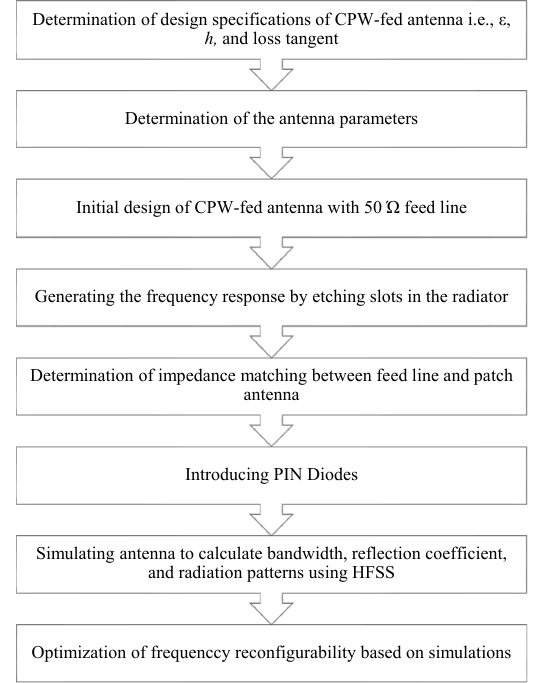
Figure 3. Flow chart of the antenna design methodology.